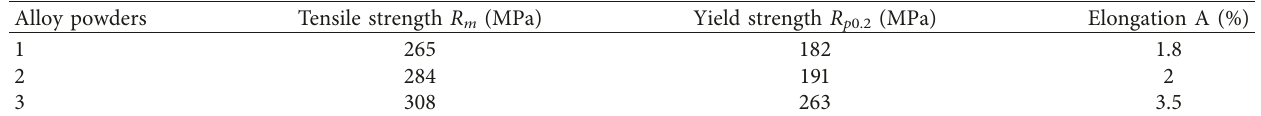
Figure 3: The micrographs of the powder compacts (a) 1, (b) 2, and (c) 3 and (d) the EDS map of point A in Table 3: Mechanical properties of the 2A12Al powder.